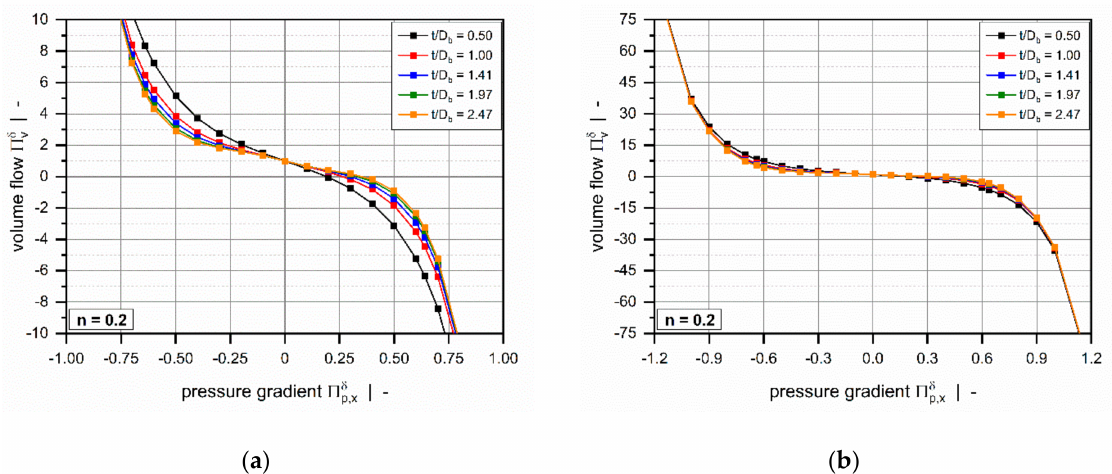
Figure 6. The volume flow rate Π δ as a function of pressure gradient Π δ p , x : Influence of screw-pitch ratio for n = 0.2. The V scaling of the diagrams was adjusted to better visualize the influence for smaller pressure gradients ( a ) and larger pressure gradients ( b ).